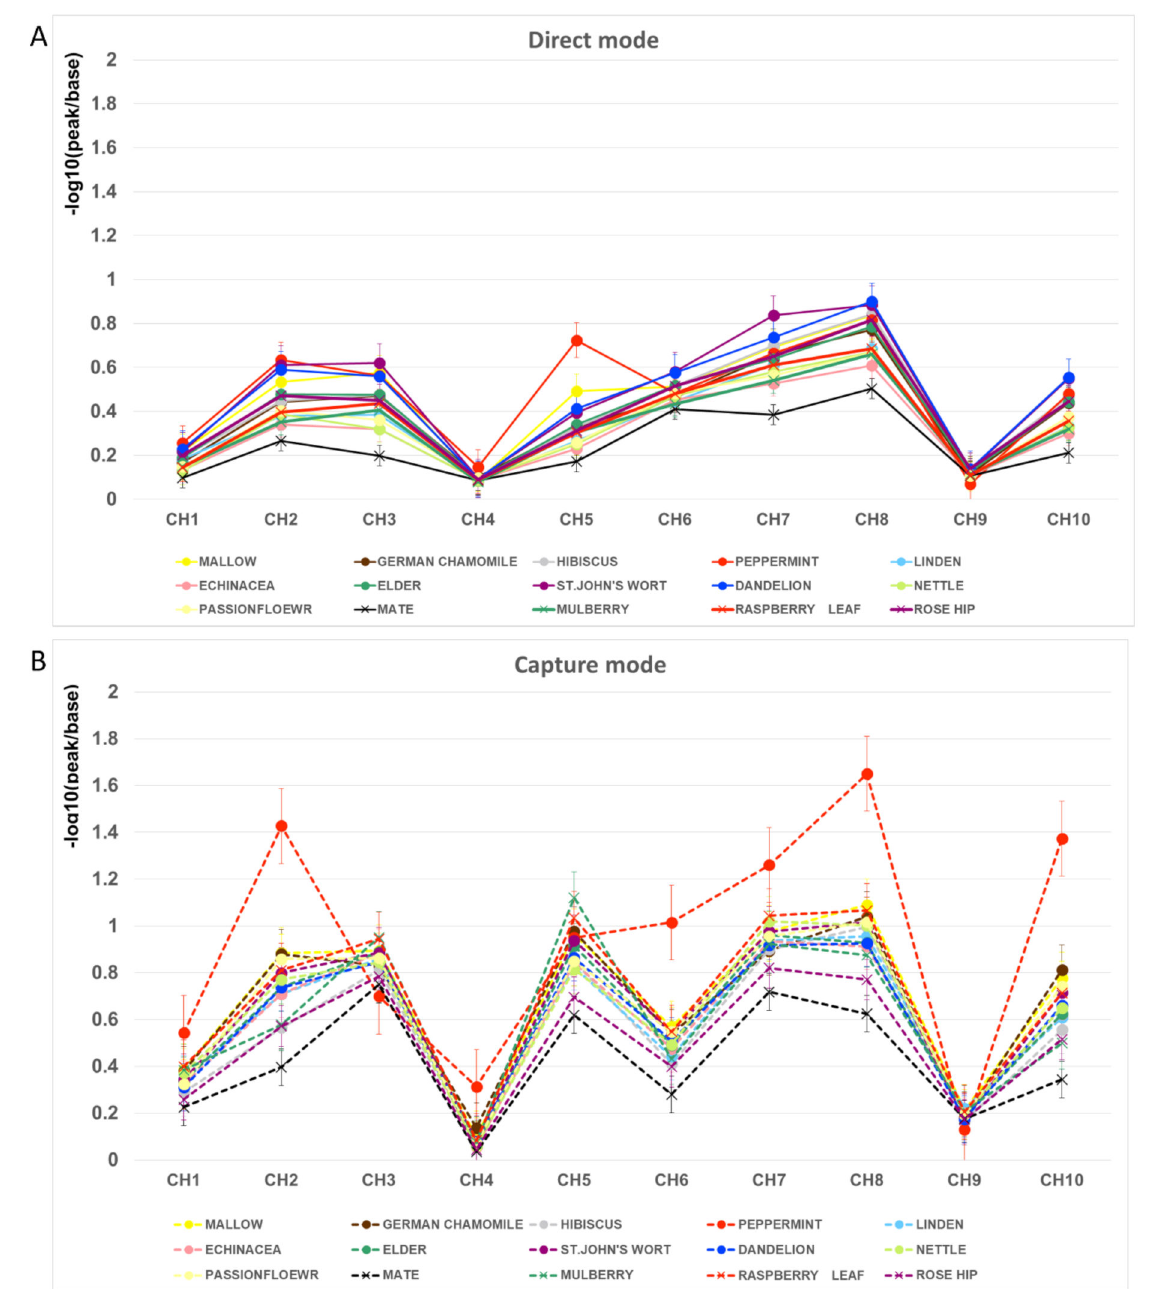
Figure 1. Reactivity of 15 kinds of herbs with each channel of the FF-2A sensor. The values are the average of three measurements. Bars represent standard error. ( A ) Measurement in Direct mode, ( B ) Measurement in Capture